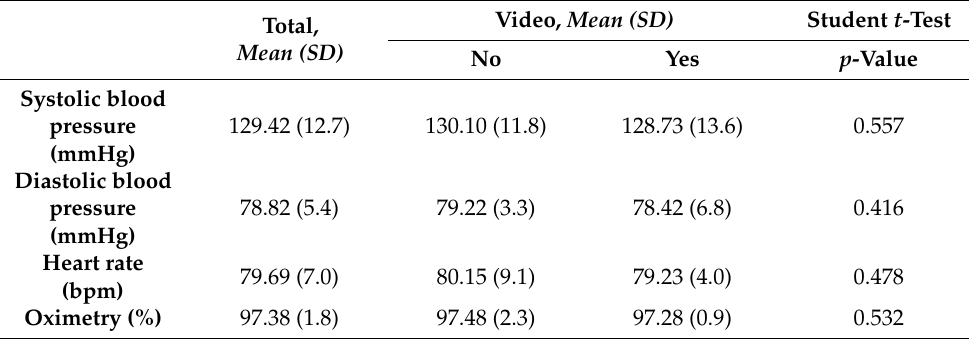
Table 3. Description and comparison of the hemodynamic